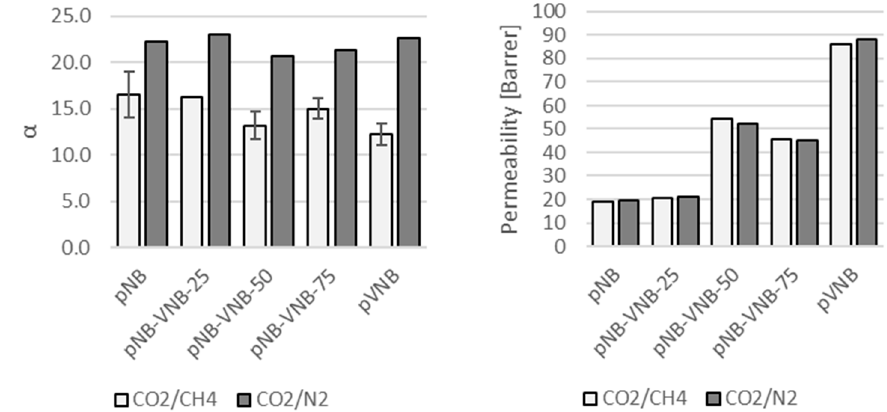
Figure 7. ( Left ) Mixed-gas selectivity and ( right ) mixed-gas permeability for CO 2 / CH 4 and CO 2 / N 2 for the series of polynorbornenes with increasing VNB content.